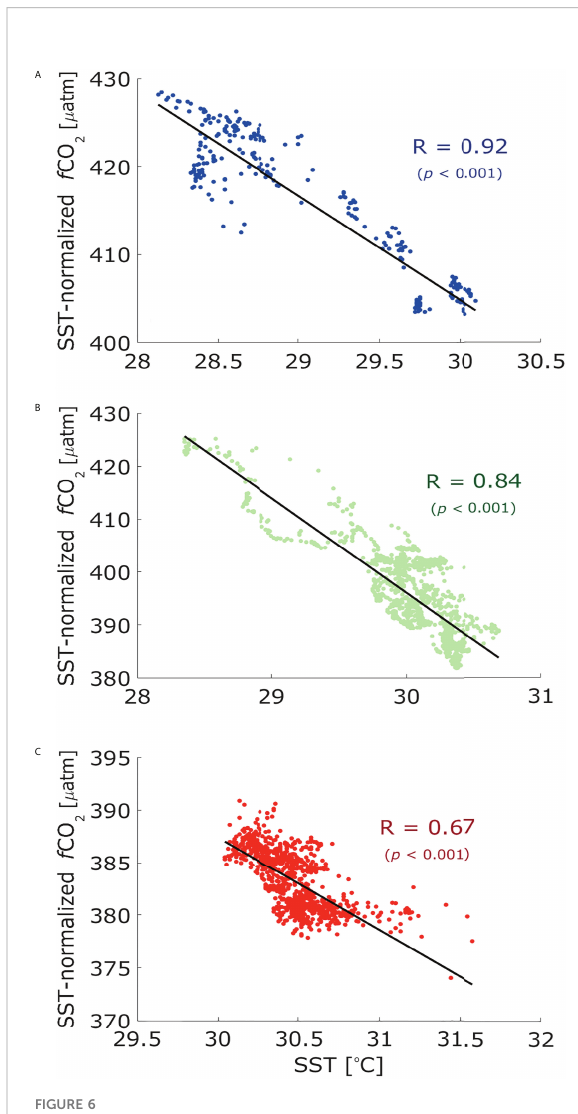
FIGURE 6 Plots of temperature-normalized fCO2 vs. SST in the cyclonic eddy (A) , non-eddy region (B) , and anticyclonic eddy (C) . Solid lines indicate linear regressions.